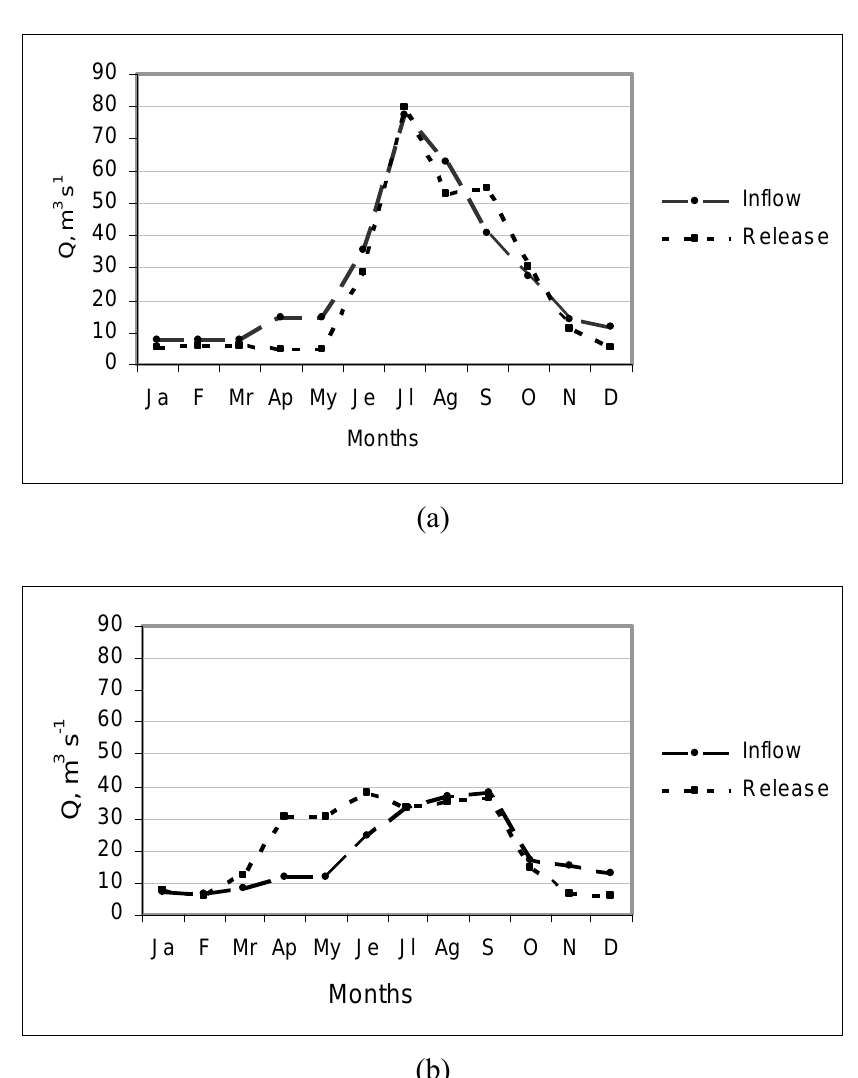
Figure 2. Inflow to and outflow from the Papan Reservoir in ( а ) high and (b) low water